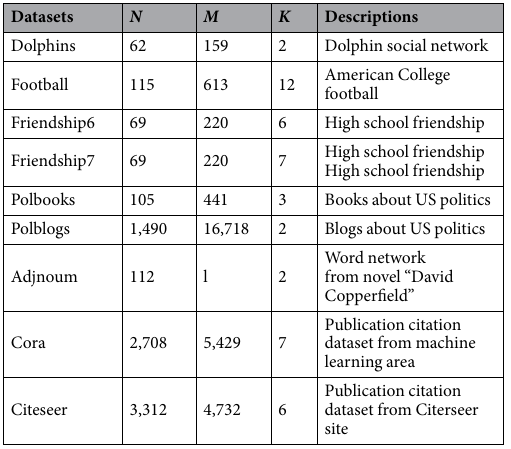
Table 1. Real-world networks used here. N , M and K are the numbers of nodes, edges and communities,